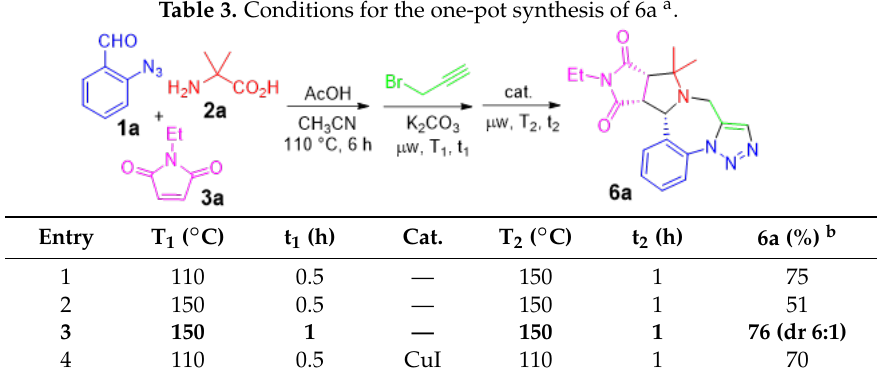
Figure 1. Double immunofluorescence staining of rat liver sections (GdCl 3 treatment) with antibodies directedagainstED-1(green)andMPO(red)followedbyfluorescenceimmunodetection. Liversections